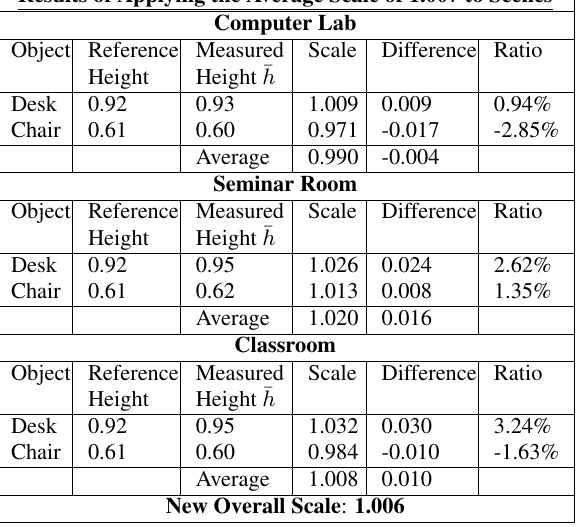
Table 5: Table showing the effect of scaling each scene using the scale obtained from the normalised height values.